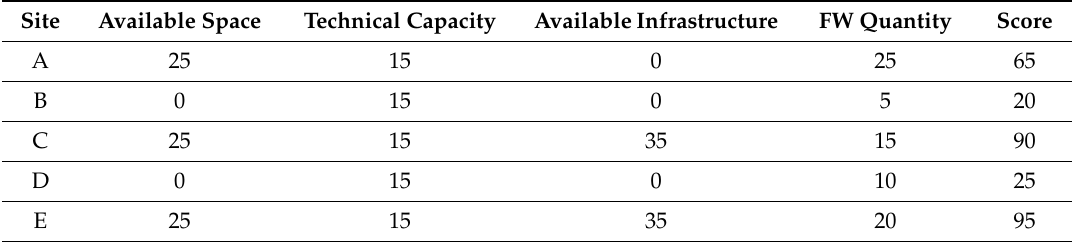
Table 3. Evaluation matrix for the selection of the FW treatment site.